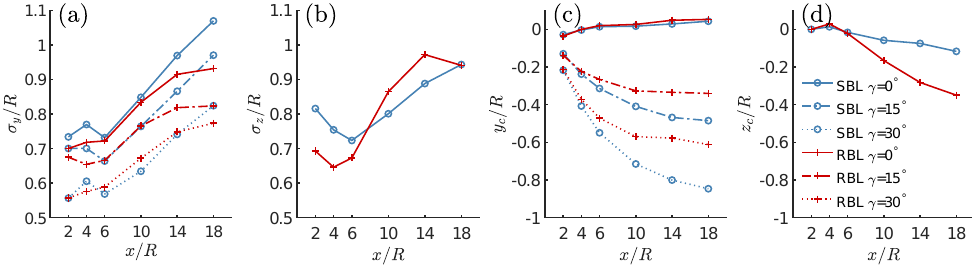
Figure 8. ( a ) Lateral and ( b ) vertical wake half widths σ y and σ z , ( c ) lateral and ( d ) vertical wake deflections y C and z C as function of the axial distance x / R . The legend indicates flow condition and yaw angle for both